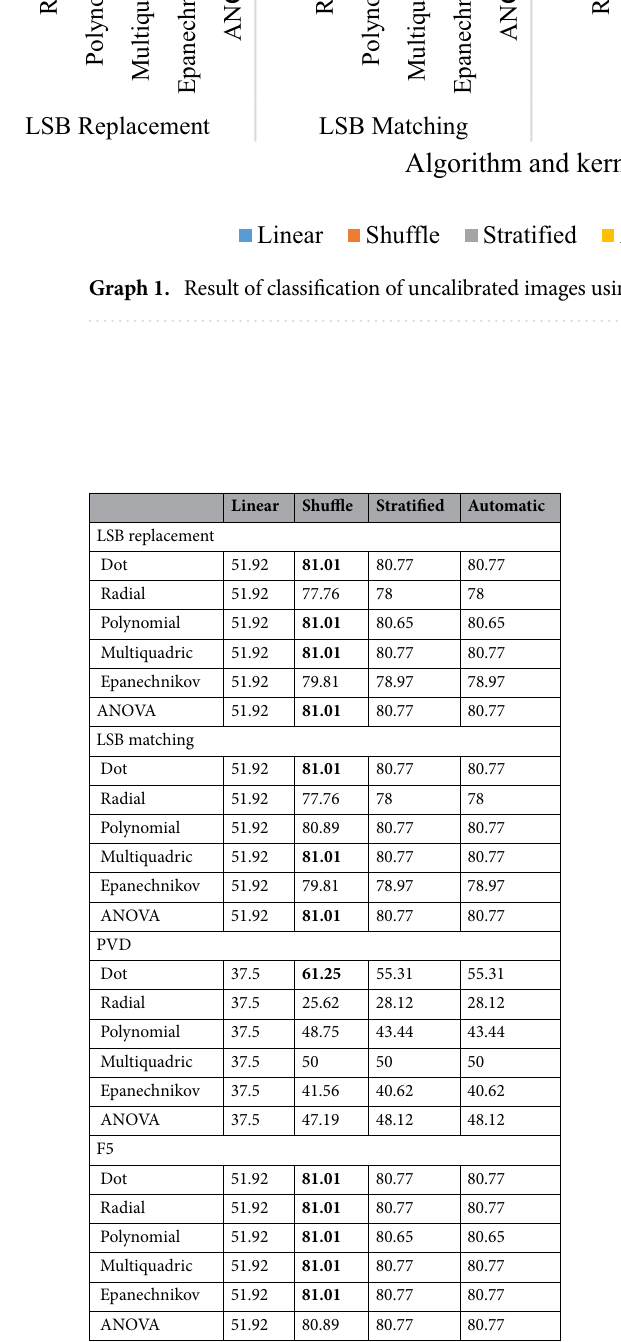
Table 4. Classification of calibrated images using SVM for random %. Significant values are in bold.